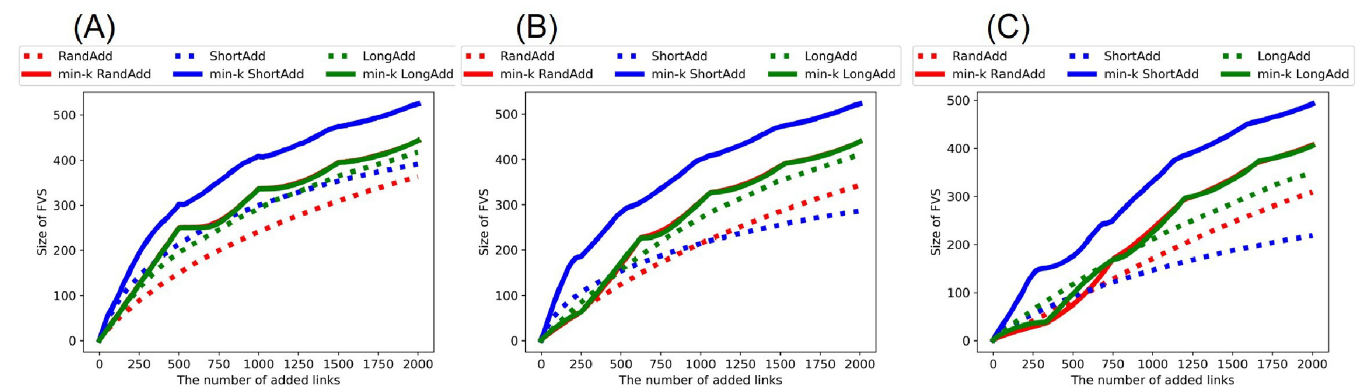
Fig 4. Size of FVS after adding links to random trees. The min- k RandAdd and min- k LongAdd methods (red and green solid lines) are effective for increasing the size of FVS. In each figure of(A)(B)(C), the min- k ShortAdd method (a blue line) outperforms the other methods. The initial random tree has (A) narrower, (B) exponential, and (C) power-law degree distributions. The correspondence between lines and methods is same as shown in Fig